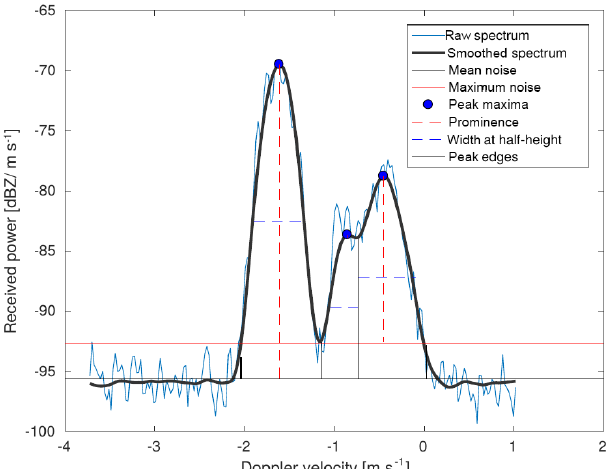
Figure 2. Example spectrum (blue line) with multiple merged peaks, recorded on 21 February 2014, 22.7UTC, at 2.44km alti- tude. The smoothed spectrum (average of neighbor spectra in time and height domain, smoothed using a span of 8.5%) is shown as well (bold black line). For each of the three peaks marked in this spectrum (blue dots), the prominences (red dashed lines) and widths at half-height (blue dashed lines) as well as the edges (vertical black lines) of the peaks are marked. The red horizontal line marks the maximum value of the power in the raw (blue) spectrum among those Doppler spectral bins identified as noise by Hildebrand and Sekhon (1974). The black horizontal line is drawn at the mean power of the Doppler bins containing only noise.